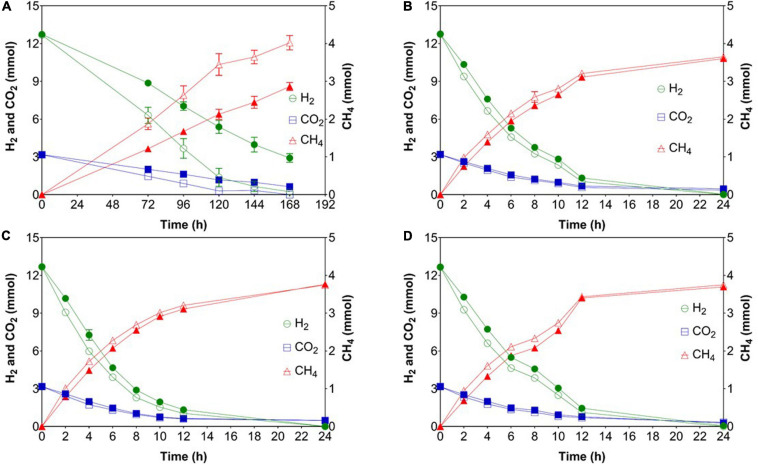
Gas consumption (H2 and CO2) and production (CH4) rates after starvation events. (A) Phase 2 (feeding without shaking), (B) phase 3 (after 7 days of starvation), (C) phase 4 (after 14 days of starvation), (D) phase 5 (after 21 days of starvation). Open symbols: reactors WW (inoculated with anaerobic granular sludge from an industrial-scale UASB reactor treating wastewater from paper industry); filled symbols: reactors PF (inoculated with digestate from a pilot-scale plug flow reactor digesting cow manure and corn silage). The mean and standard deviation of n = 4 are depicted.